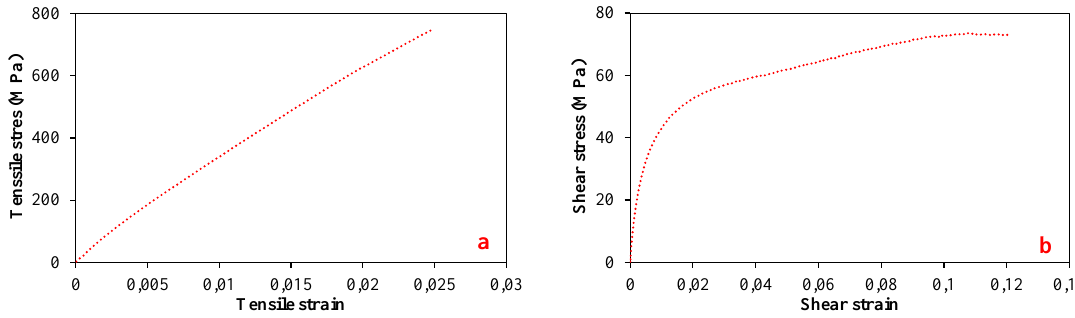
Figure 2: Stress-strain curve of: (a) tensile and (b) shear